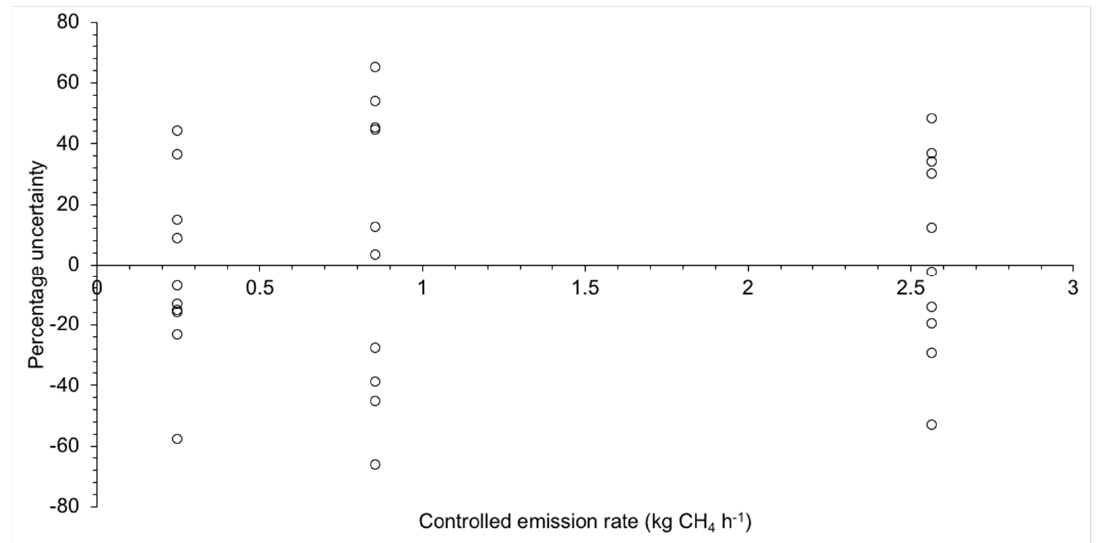
Figure 2. Percentage uncertainty, calculated from known and measured emission rates, of controlled release uncertainty analysis performed at Colorado State University’s Methane Emissions Technology Evaluation Center (METEC) facility in Fort Collins, CO, USA. Compressed natural gas was released at 1.5 m above the ground at the center of the site at 0.25, 0.86 and 2.6 kg CH 4 h − 1 and mixing ratios measured inside a vehicle moving around the site at 16 km h − 1 .